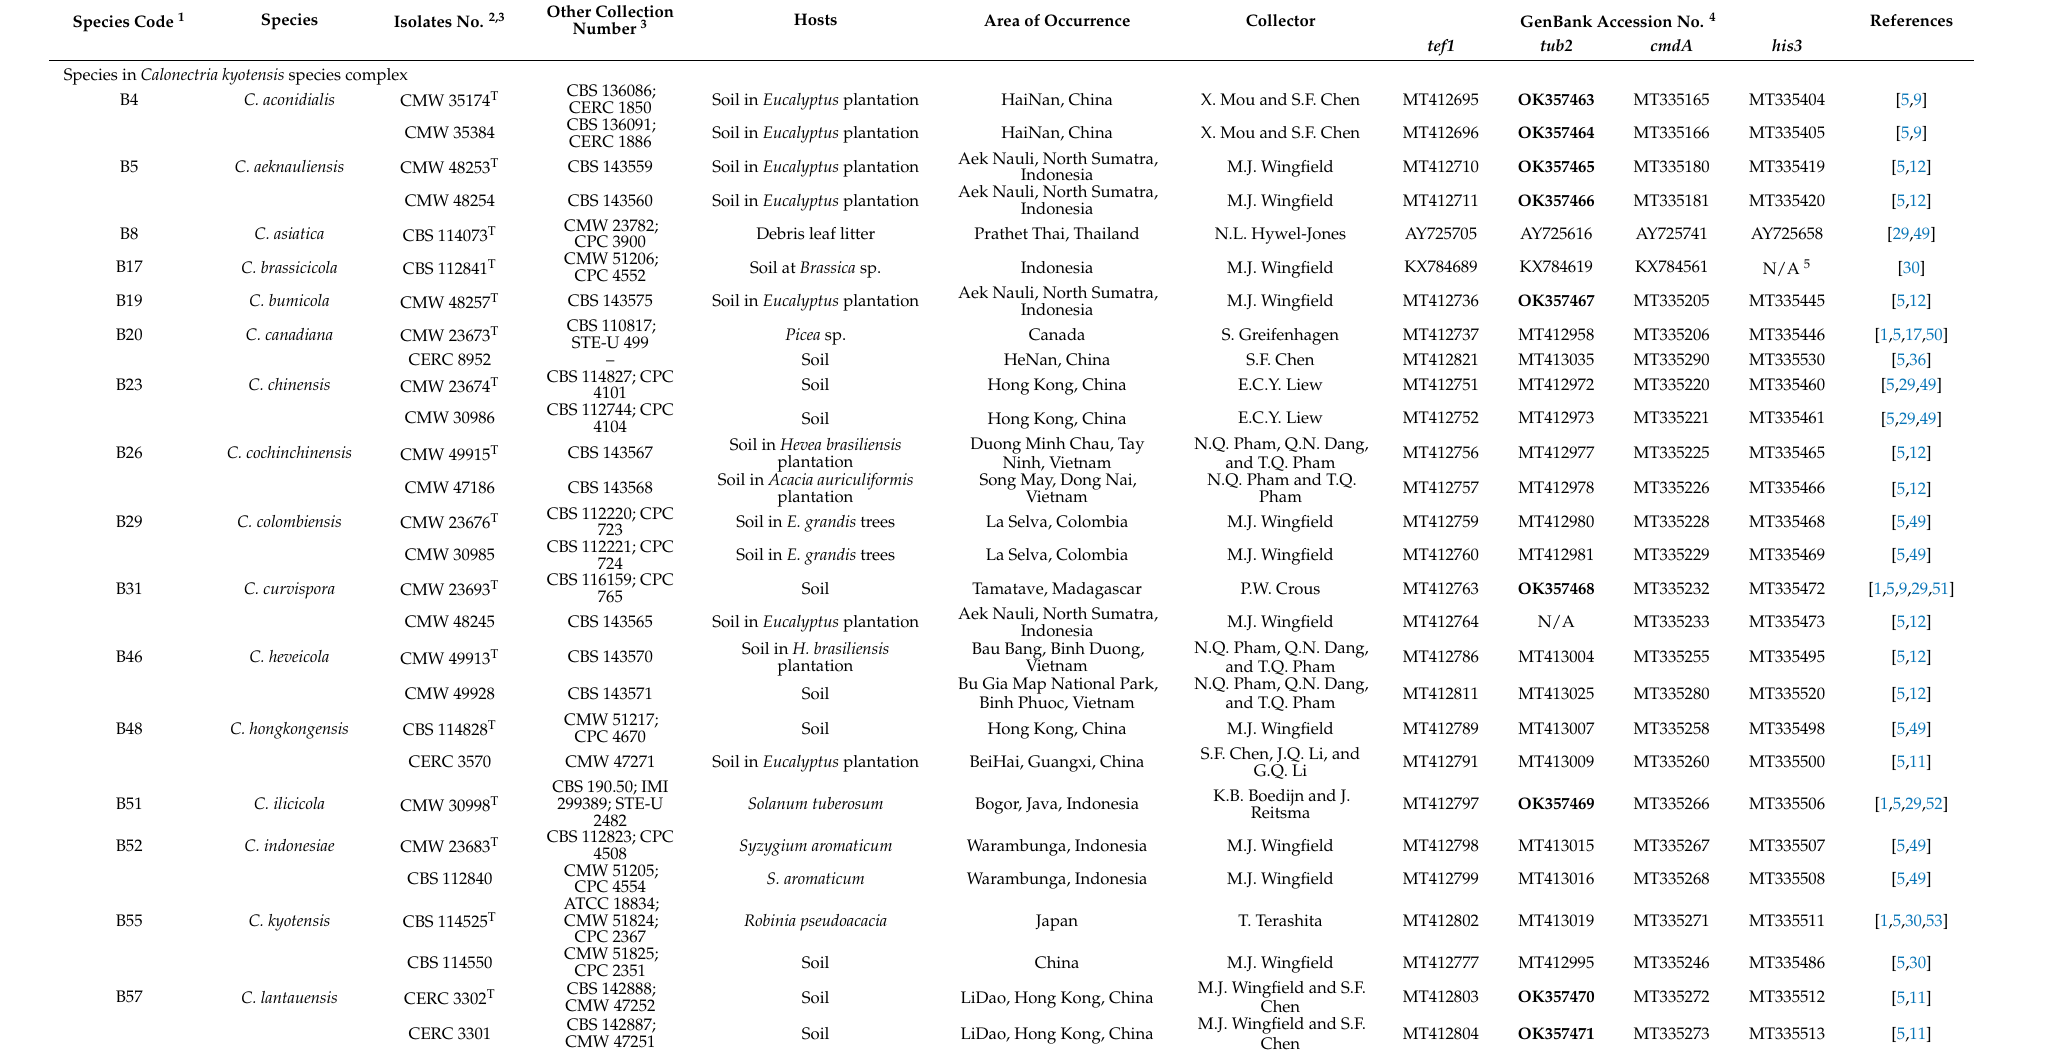
Table 4. Isolates from other studies used in the phylogenetic analyses in this